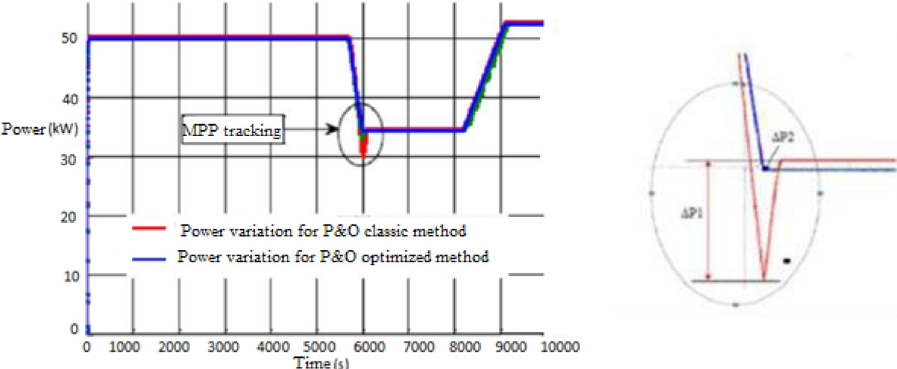
Fig. 13. Power variation and power loss for each algorithm.